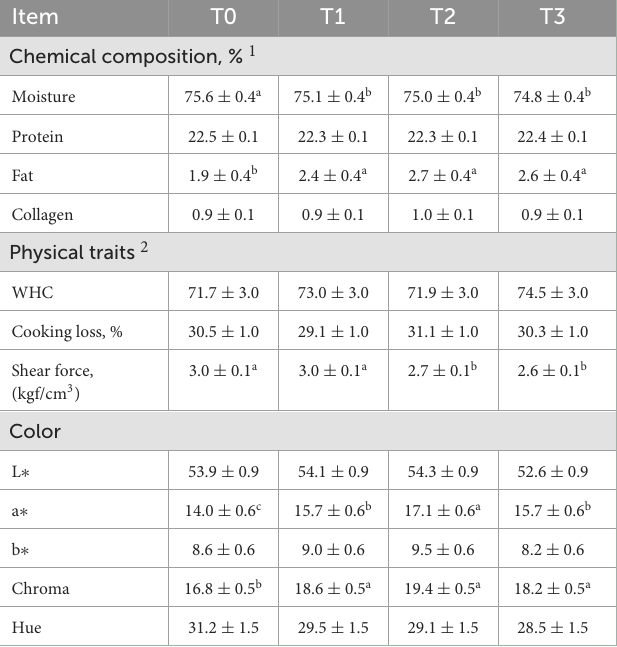
TABLE 6 The least-square means ± standard error of chemical composition and physical traits in the different groups studied.